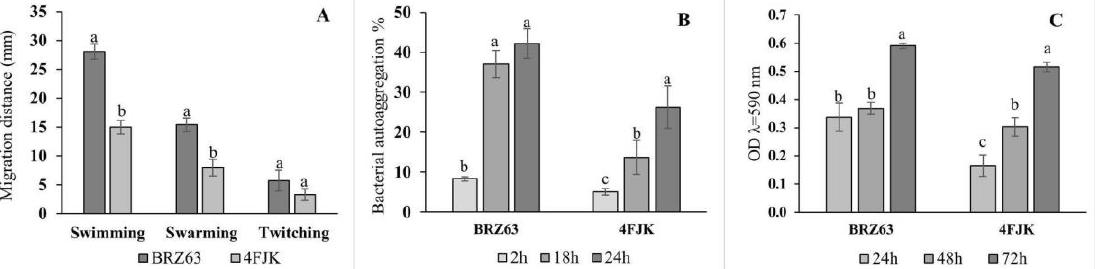
Figure 2. Motility ( A ), autoaggregation ( B ), and biofilm formation ability ( C ) of P. fluorescens BRZ63. The Enterobacter asburiae 4FJK strain was used as a control strain. The autoaggregation ability of the tested strains is expressed as a percentage of aggregated cells after 2, 18, and 24 h of incubation. The biofilm formation was assessed over a period of 72 h by using the crystal violet (CV) method. Each column represents the mean ± standard deviations of three independent replications for each treatment. a,b,c−indicate statistically significant differences ( p < 0.05) according to the HSD test.